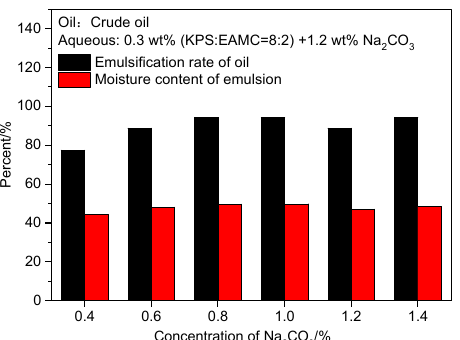
Figure 8. The effect of Na 2 CO 3 on the emulsification properties of KPS and EAMC solution.